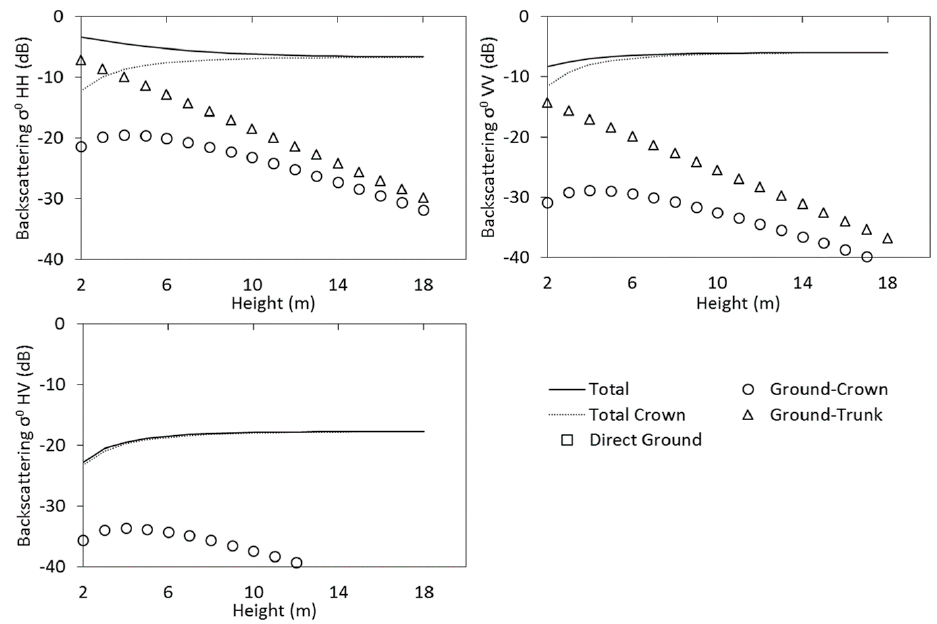
Figure 6. Total co- and cross-polarised canopy backscatter components vs. canopy stand height (m) from 830 leaves and 4.1 branch density Birch for S -band at 30° incidence angle.